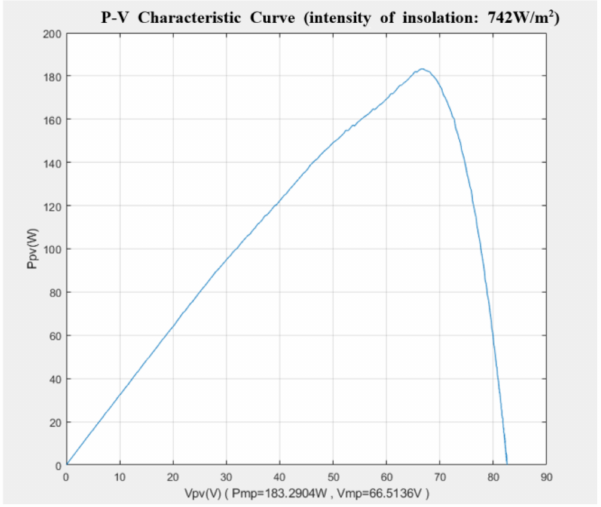
Figure 6. P-V characteristic curve of the photovoltaic module array in Case 1 (with single-peak